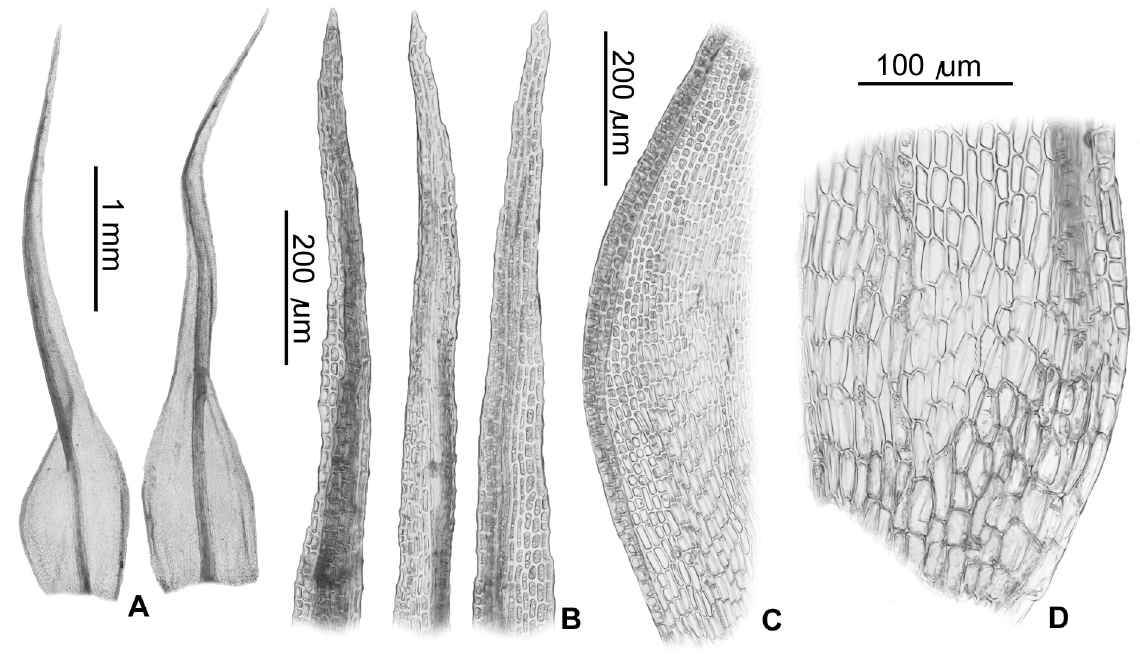
Fig. 10. Oncophorus integerrimus Hedenäs sp. nov (holotype). A . Stem leaves. B . Upper leaf acumen. C . Portion of leaf at widest point, showing the broadly recurved margin. D . Lower part of sheathing leaf portion, showing differentiated alar region (margin to the